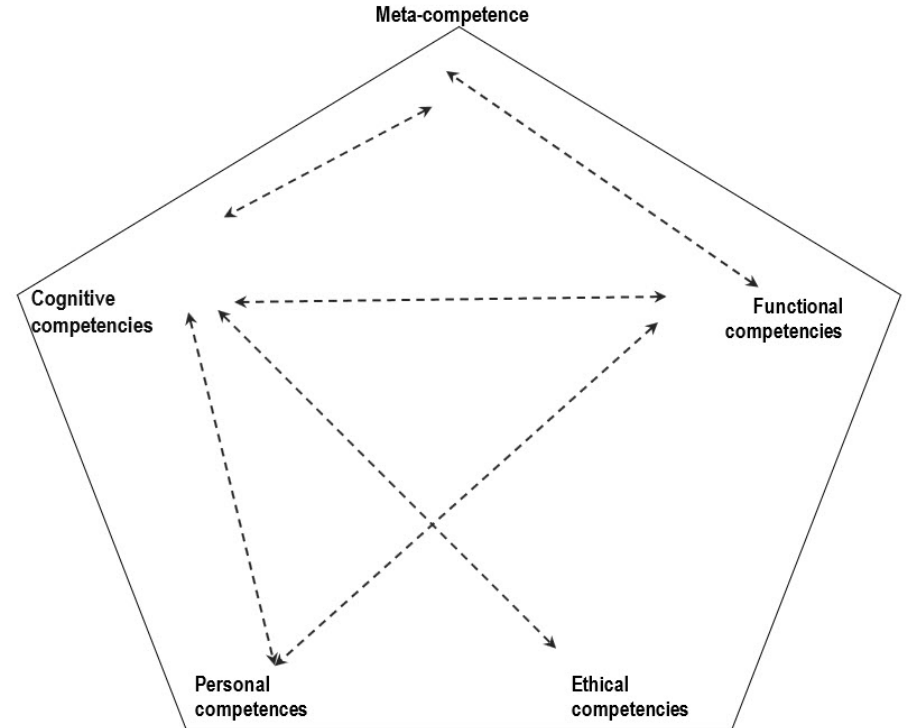
Figure 1. Model of 5-component specialist